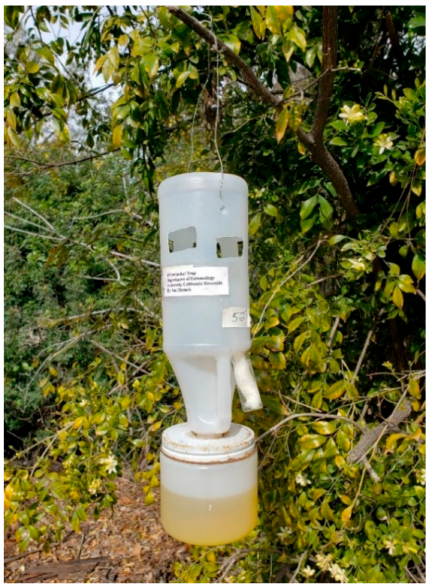
Figure 3. The UCR-style trap with re-useable and interchangeable